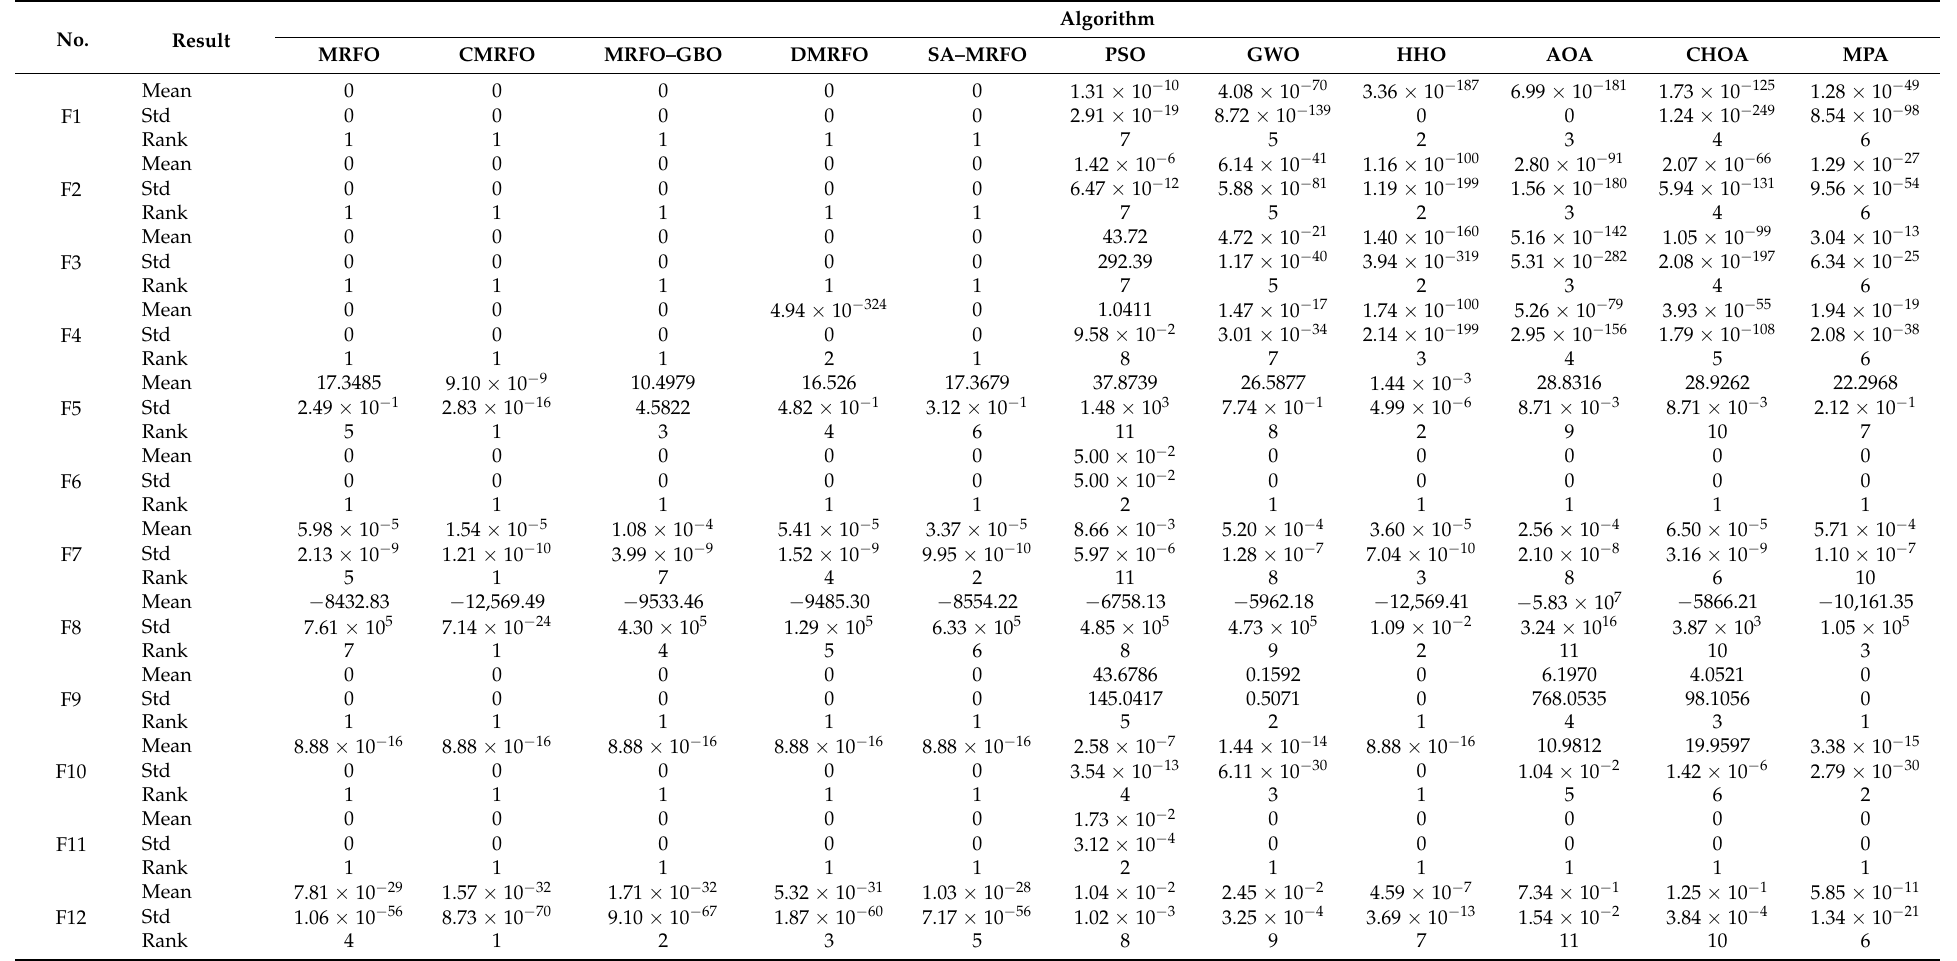
Table 6. Comparison results of all 11 optimizers on 23 classical